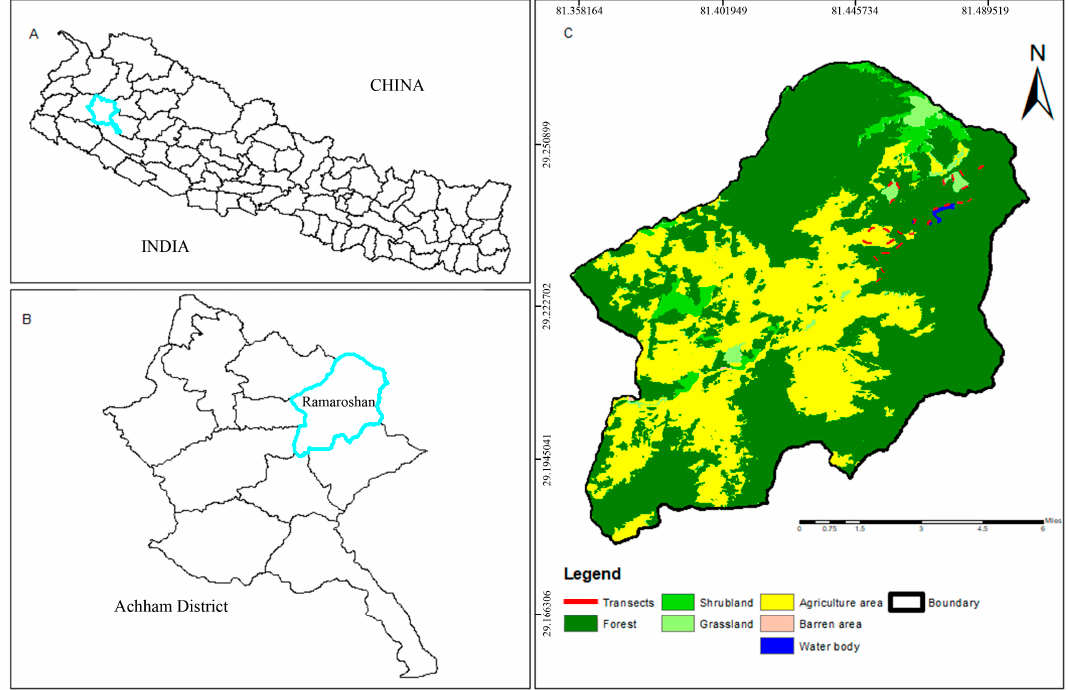
Figure 1. Map of the study area. ( A ) Map of Nepal showing Achham District; ( B ) Map of Achham District showing Ramaroshan Rural Municipality; and ( C ) Map of Ramaroshan Rural Municipality showing transects around the Ramaroshan Wetland